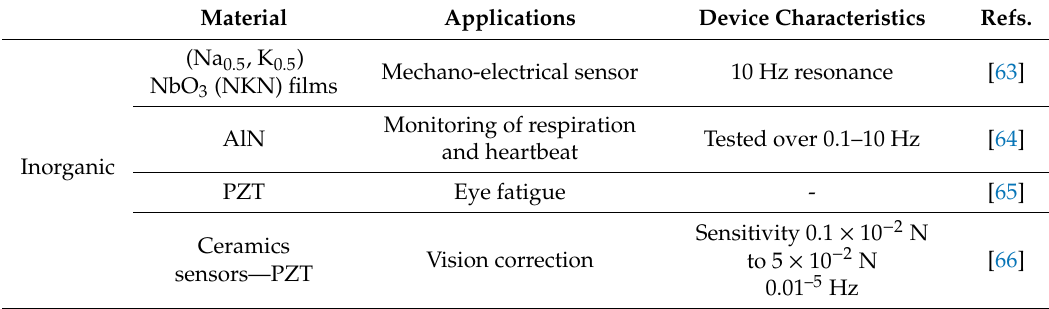
Table 3. Inorganic piezoelectric sensors for di ff erent medical